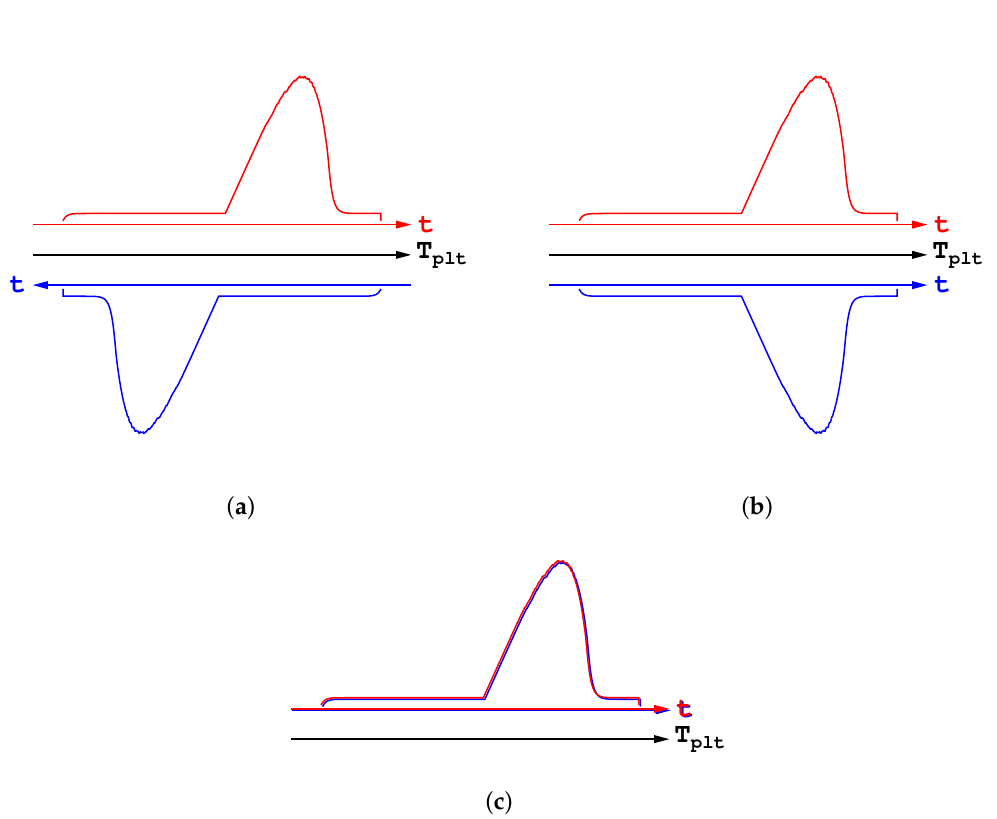
Figure 16. Schematic demonstration of the non-existence of any hysteresis phenomenon for a pure substance. ( a ) Initial thermograms for heating (red) and cooling (blue); ( b ) Symmetry over time; ( c ) Sign change for heat flux (endo vs.